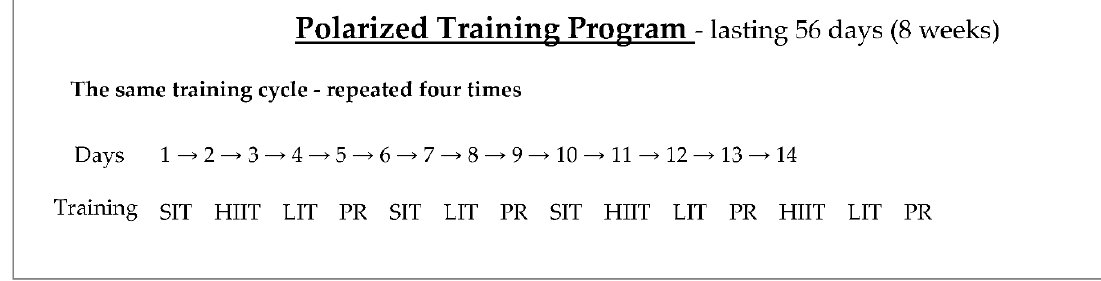
Figure 2. Scheme of the polarized training program (SIT–sprint interval training; HIIT–high-intensity interval training; LIT–low-intensity training; PR–passive rest).